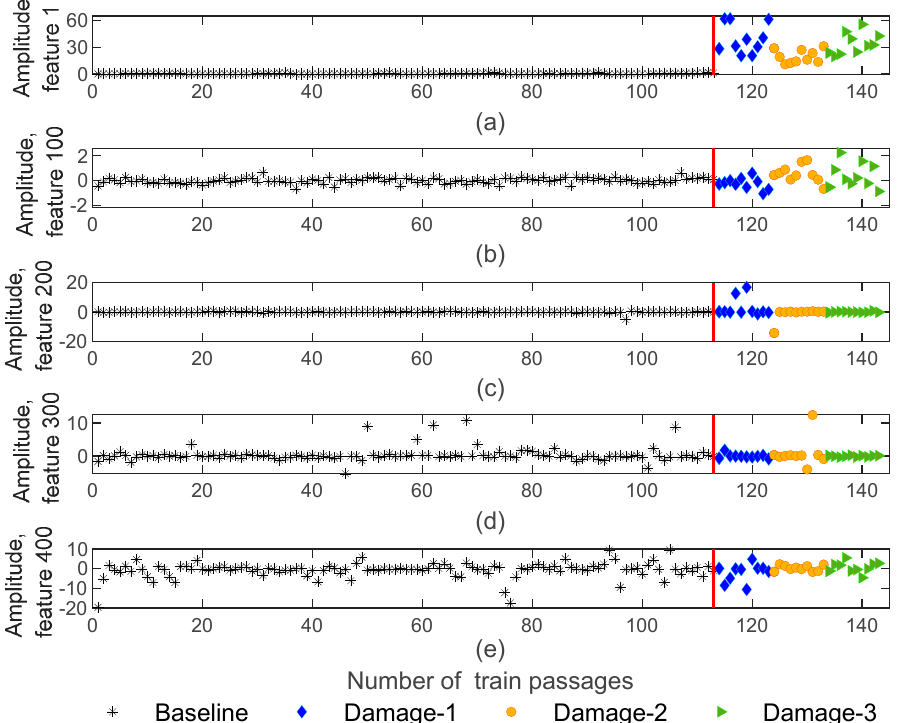
Figure 10. CWT—feature extraction for all 143 baseline and damage scenarios for accelerometer 3: ( a ) amplitude for feature 1, ( b ) amplitude for feature 100, ( c ) amplitude for feature 200, ( d ) amplitude for feature 300, ( e ) amplitude for feature 400.